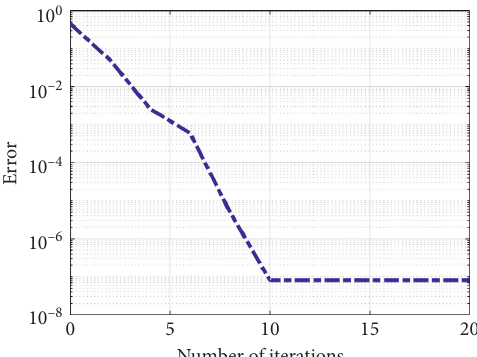
Figure 6: BPNN training error curve.